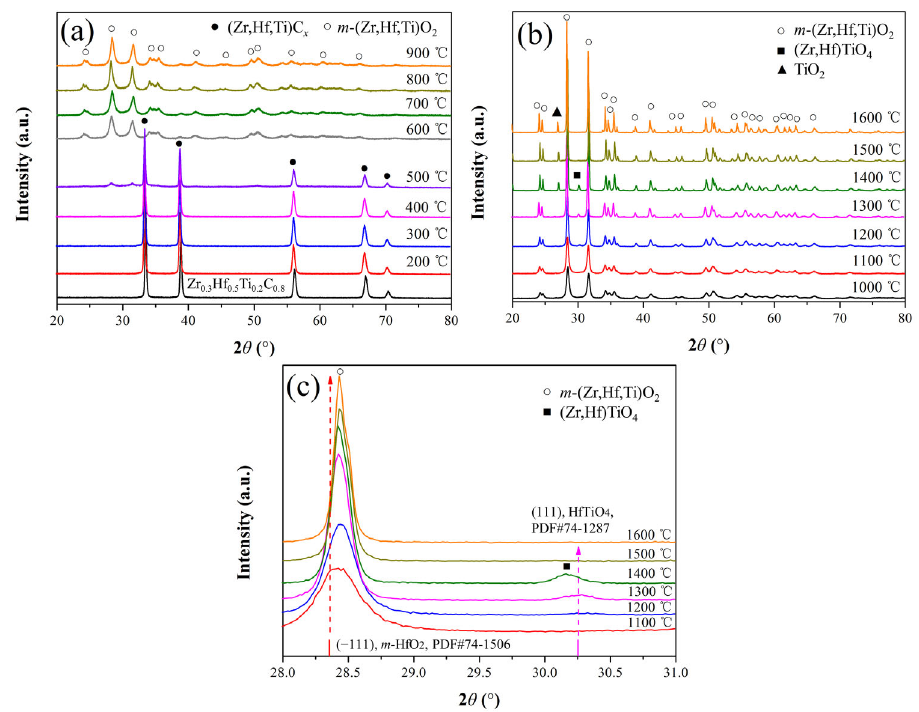
Fig. 6 XRD patterns of Zr 0.3 Hf 0.5 Ti 0.2 C 0.8 after being oxidized at different temperatures: (a) 200–900 ℃ and (b) 1000–1600 ℃ ; (c) the enlargement patterns of 1100–1600 ℃ from 28.0° to 31.0°.